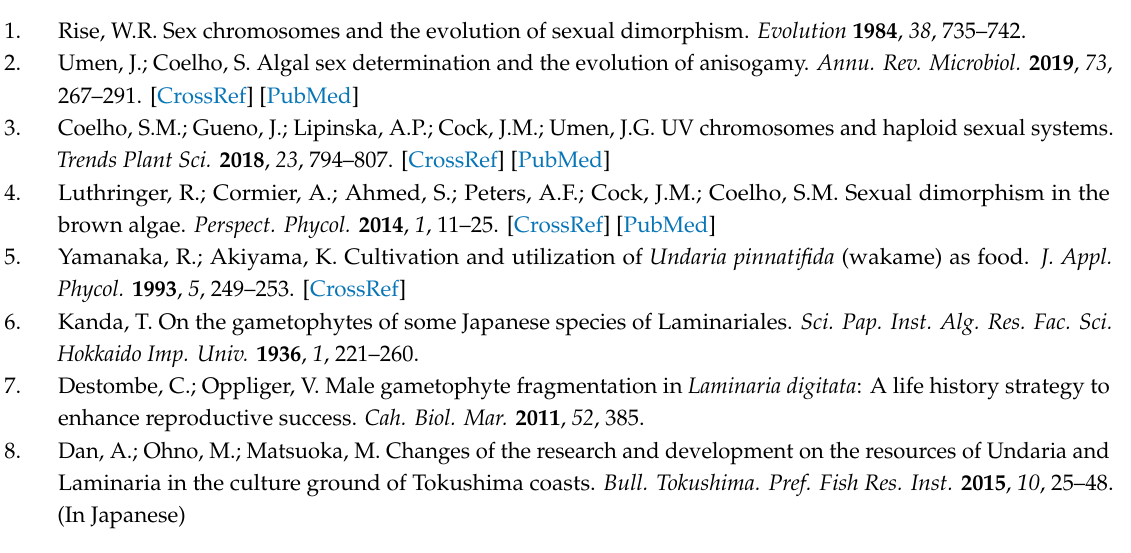
Figure S1. The appearance of di ff erent morphological forms of Undaria pinnatifida during its life cycle. a. Male gametophyte (left) and female gametophyte (right). b. Fertilized sporophytes (black arrow) and eggs (white arrows) on the female gametophyte. c. Juvenile sporophyte. d. Mature sporophytes formed sporophylls. Vertical bars indicate 10 cm. Supplemental Figure S2. Fifteen incubators for this study and four light colors. Supplemental Figure S3. Representative photographs of gametophytes measured area for growth estimation by a picture analysis. a. An original picture, b. a picture processed the outline formation with separation and binding. Supplemental Figure S4. Mean annual seawater temperature range (for the first, middle, and last third of each month) at the three regions from which U. pinnatifida sporophytes were collected (see Materials and Methods for details of data collection and treatment): IWT, Iwate Pref.; TKS, Tokushima Pref.; KGS, Kagoshima Pref. Supplemental Figure S5. RSM analysis of simulated growth of male and female gametophytes for IWT, TKS, and KGS. RGR (day − 1 ) versus seawater temperature, light intensity, and light color. Supplemental Table S1. RSM simulation of results for RGR in male and female gametophytes of each line of U. pinnatifida , based on an experimental matrix built using a graphical experimental design (Table 1). Supplemental Table S2. Regression coe ffi cients of polynomial functions of response surface for RGR of male and female gametophytes at Iwate (IWT), Tokushima (TKS), and Kagoshima (KGS). Supplemental Table S3. OLR simulation of results for maturation degree V on cultivation day 25 in male and female gametophytes of each line of U. pinnatifida , based on an experimental matrix built using a graphical experimental design (Table 2). Supplemental Table S4. Regression coe ffi cients of polynomial